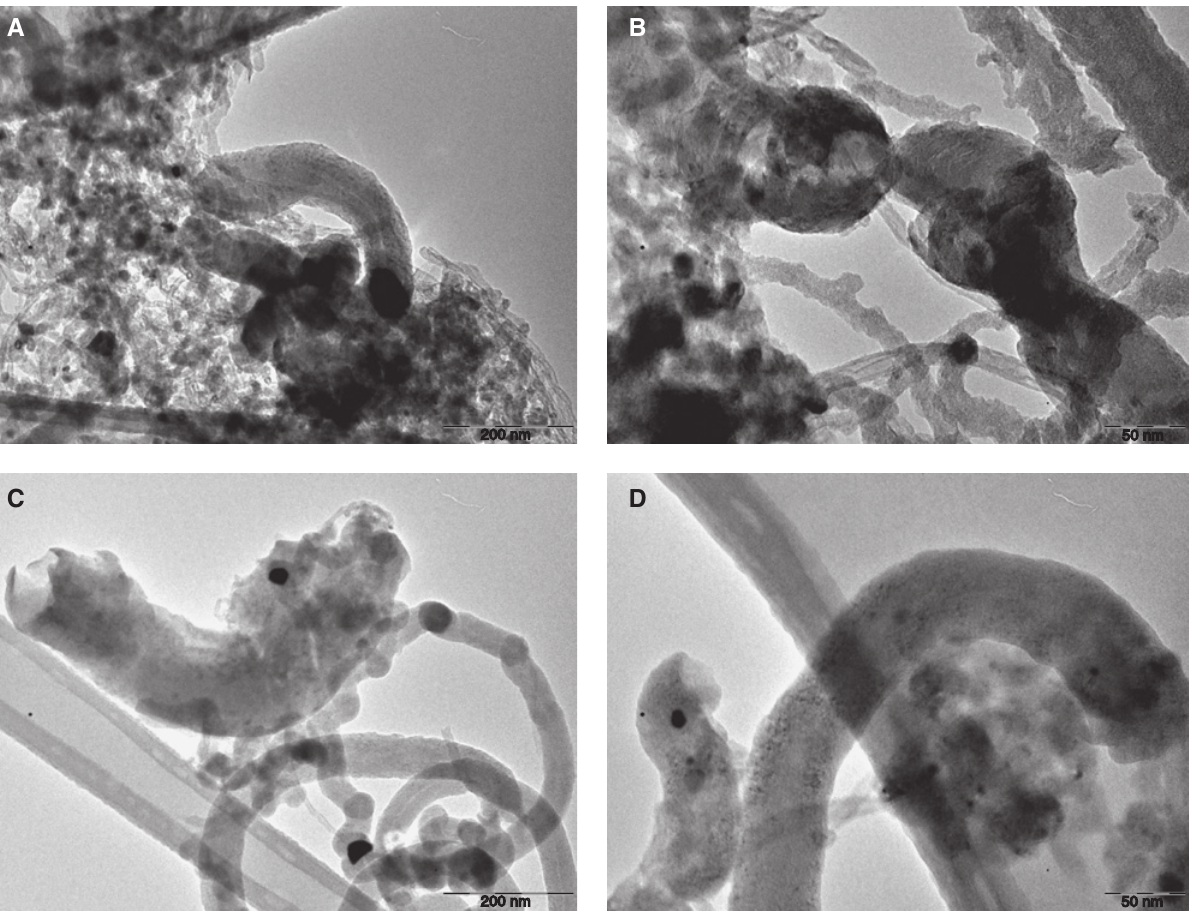
Figure 9: Different types and shapes of carbon formed over carbon nanotube (CNT)-based catalysts during steam reforming of ethanol (SRE). Energy filtered transmission electron micrographs of used catalysts at different magnifications (A, B) Ni